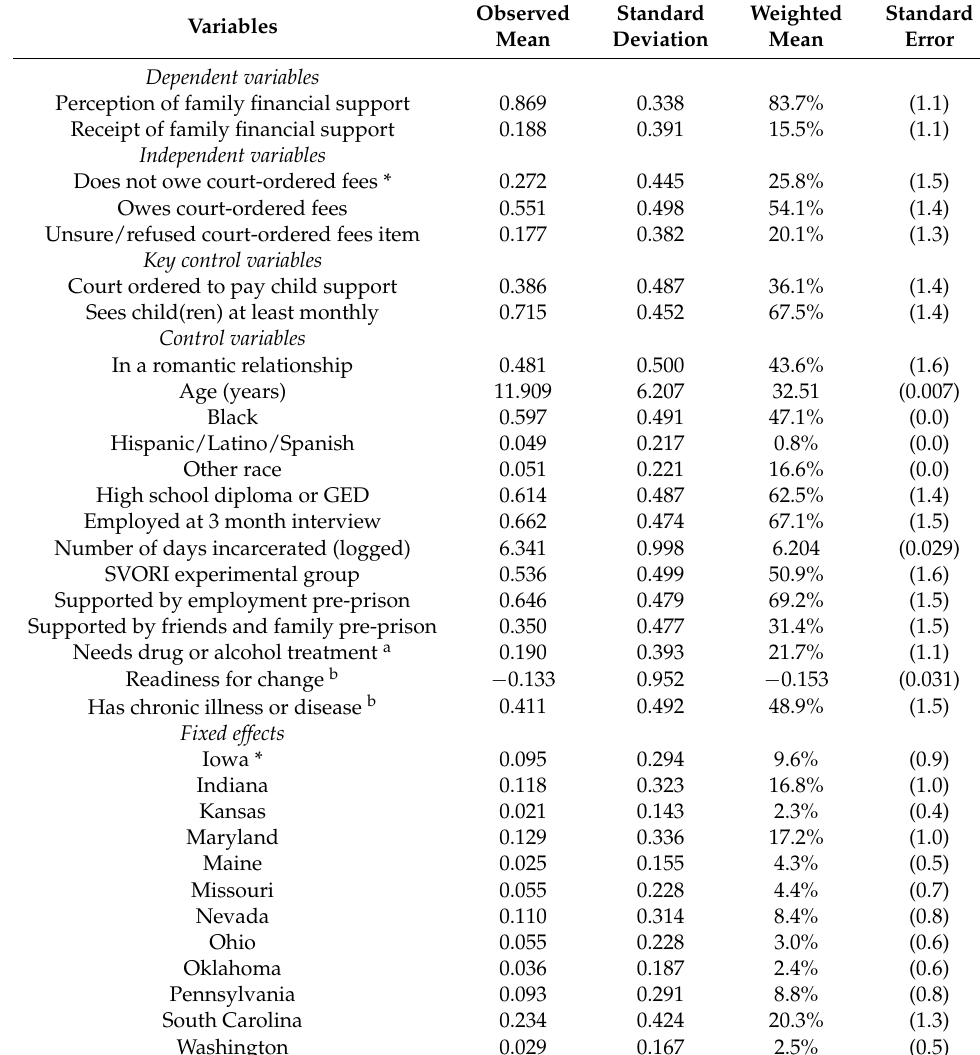
Table 1. Descriptive Statistics for all Study Variables ( n =